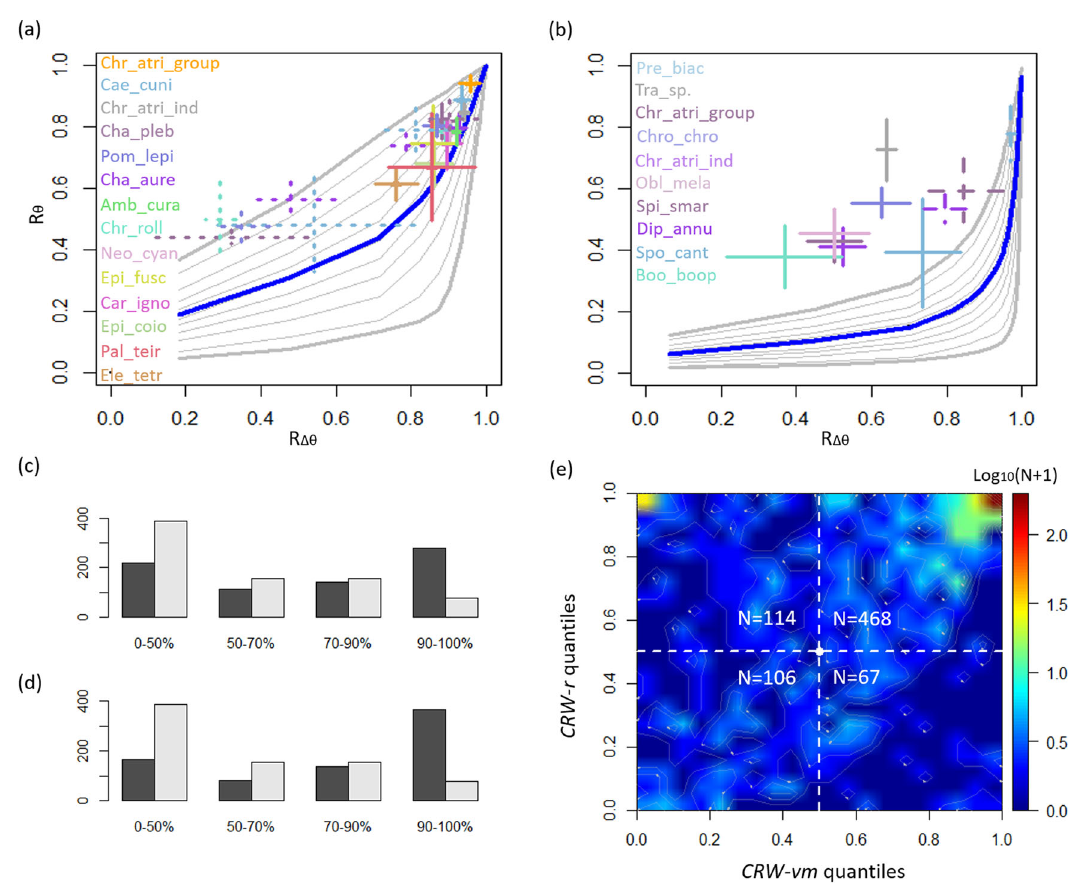
Fig. 1 Results of Correlated Random Walk-von Mises ( CRW-vm ) and Correlated Random Walk resampling ( CRW-r ). CRW-vm analysis at the species level based on the diagram in Fig. 2c for the scuba-following trials ( a ), and for the DISC trials ( b ) with various number of samples-per-trial: N obs = 21 (a), 300, 90, and 180 ( b ). Crosses represent means ± 95% CI of the observed ( R Δθ , R θ ) pooled by species. Crosses with dashed lines in b represent species with N obs different than 180, see Table 1 for more details. The 5th, 10th, 20th, … ., 90th, and 95th quantiles of the R θ vm contours, with thicker contours for the 5th and 95th quantiles. Thick blue line in a and b represents (cid:2) R θ vm their R θ means and correspond in color to their respective crosses in a and b . Crosses with dotted lines in a represent DISC trials, which were subsampled to N obs = 21; for these species, colors match the names in b . The species ’ full names are provided in Table 1. Chi-square goodness of fi t plots comparing the ^ R θ quantiles distributions (black bars) to the null quantile distributions (grey bars) for CRW-vm ( c ) and CRW-r ( d ). e A heatmap of all trial counts binned at 5% increments according to their ^ R θ quantiles in the CRW-vm and CRW-r